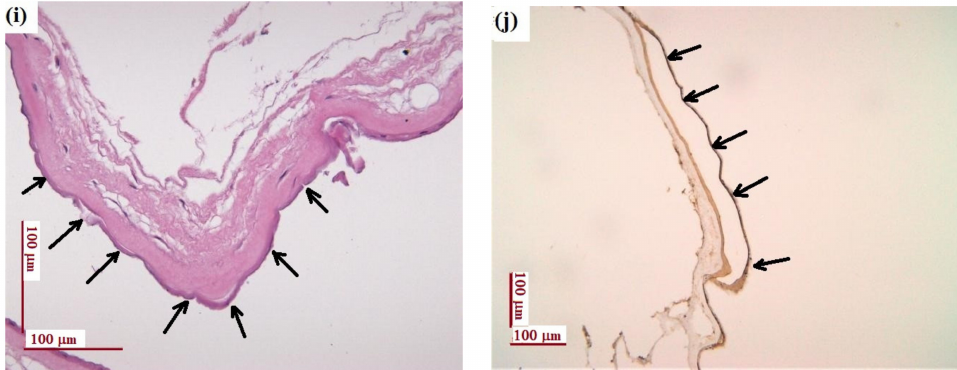
Figure 2. Histological and immunohistochemical examination: ( a , b ) natural amniotic membrane (AMN); ( c , d ) amniotic membrane exposed to UV for 1 h (AUV); ( e , f ) amniotic membrane treated with gentamicin (40 mg/mL) (AG40); ( g , h ) amni- otic membrane treated with gentamicin 80 mg/mL (AG0); ( i , j ) amniotic membrane treated with gentamicin 40 mg/mL and exposed to UV for 1 h (AGUV). Left panel: H&E staining; right panel: immunohistochemistry staining of collagen IV (antibody clone CIV 22). Scale: 100 µ